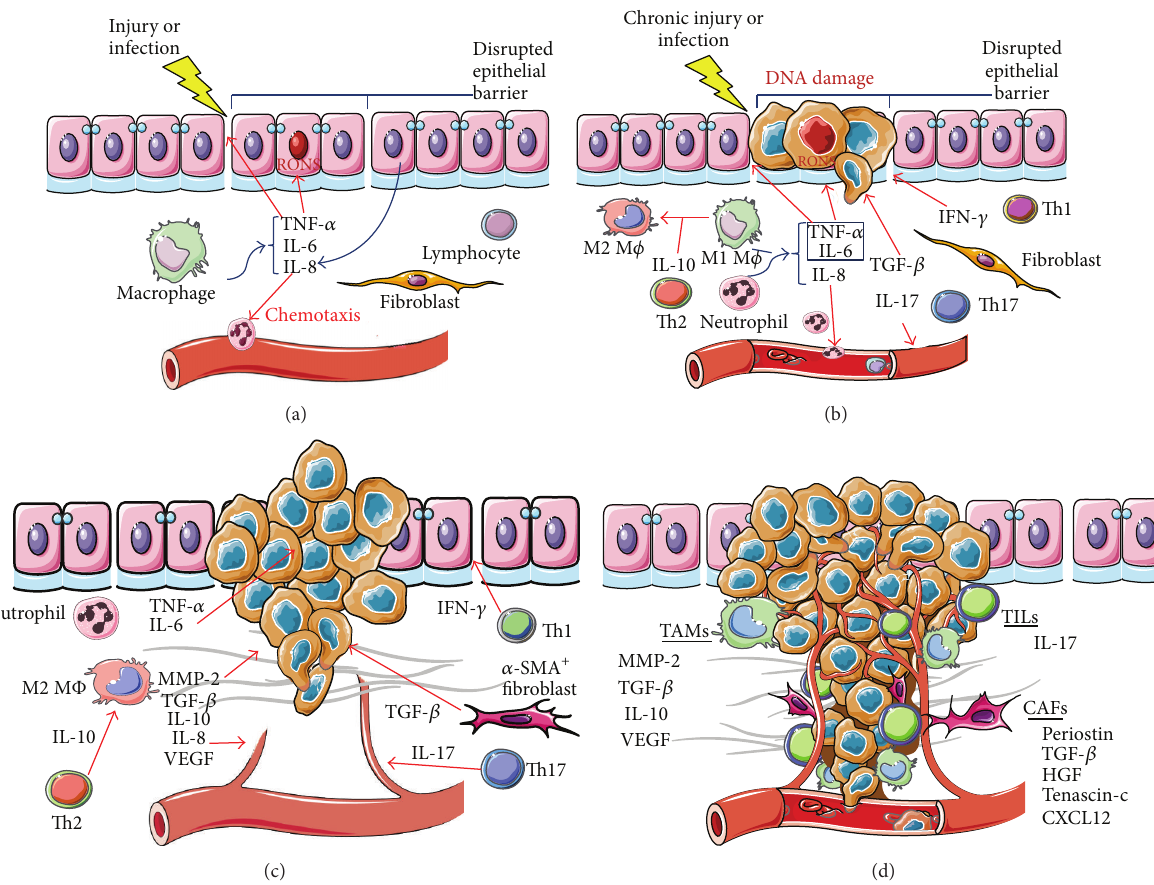
Figure 1: Schematic illustration of the role of cytokines in carcinogenesis. (a) During tissue injury or infection, an immune response activates the expression of proinflammatory mediators, such as TNF- 𝛼 , IL-6, and IL-8 from macrophages and neutrophils. These cytokines can disrupt the epithelial barrier, induce RONS, and promote the infiltration of other inflammatory cells. (b) In chronic inflammation, proinflammatory cytokines such as TNF- 𝛼 can induce DNA damage through RONS, which leads to tumor initiation. TGF- 𝛽 can promote malignant transformation through EMT activation. Cytokines derived from CD4 + lymphocytes, such as IFN- 𝛾 , IL-10, and IL-17, can participate in epithelial barrier disruption, M2 phenotypic transitions of macrophages, and angiogenesis, respectively. (c) Tumor growth and invasion are also favored by proinflammatory cytokines that stimulate cell proliferation, reduce apoptosis, and enhance EMT and angiogenesis; the latter is facilitated by VEGF and IL-8. Anti-inflammatory cytokines, such as IL-10 and TGF- 𝛽 , contribute to tumor immune evasion. (d) Tumor- associated macrophages (TAM), tumor-infiltrating lymphocytes (TIL), and cancer-associated fibroblasts (CAF) secrete several factors that contribute to tumor growth and metastasis, while maintaining the immunosuppressive